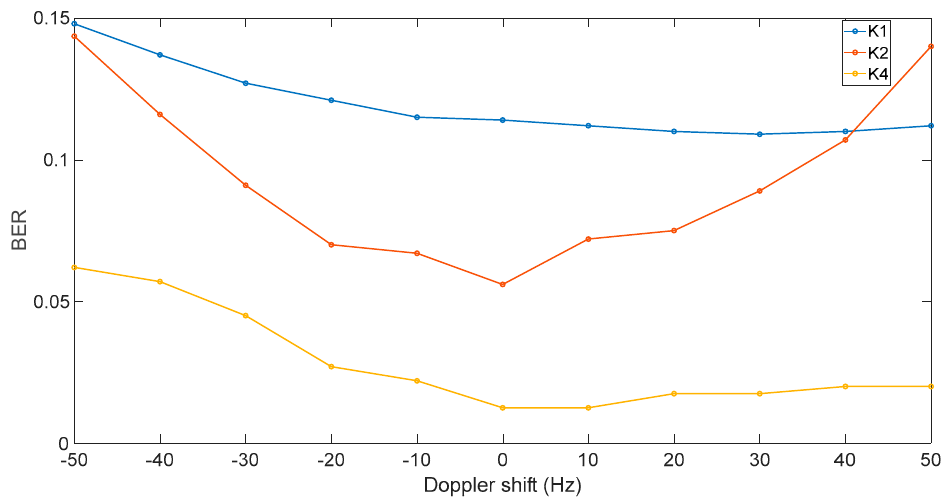
Figure 9. BER of received signals of K1, K2, and K4 modes under artificial Doppler shift adding.